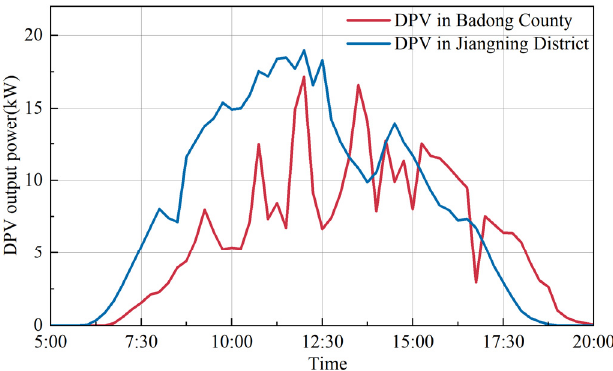
Figure 4. Badong county and Jiangning district DPVS output on a typical day.